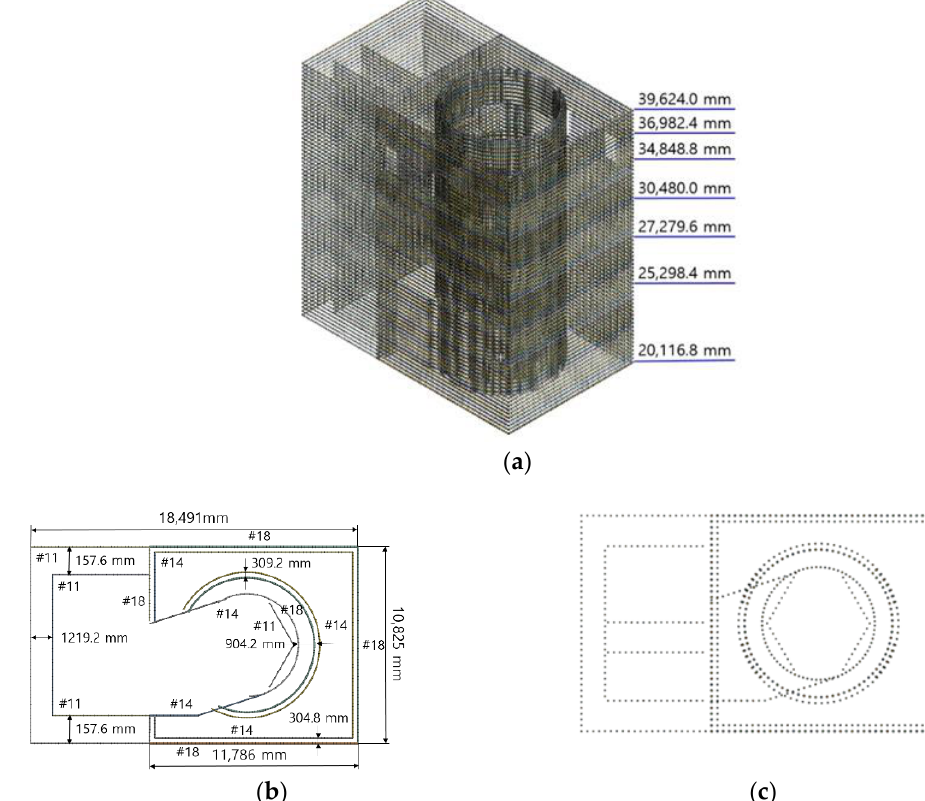
Figure 2. Schematic diagram showing the arrangement of the rebars. ( a ) The overall arrangement of the rebars and height information. ( b ) The horizontal arrangement at heights in the 20,116–25,298 mm range. ( c ) The vertical arrangement of the rebars.